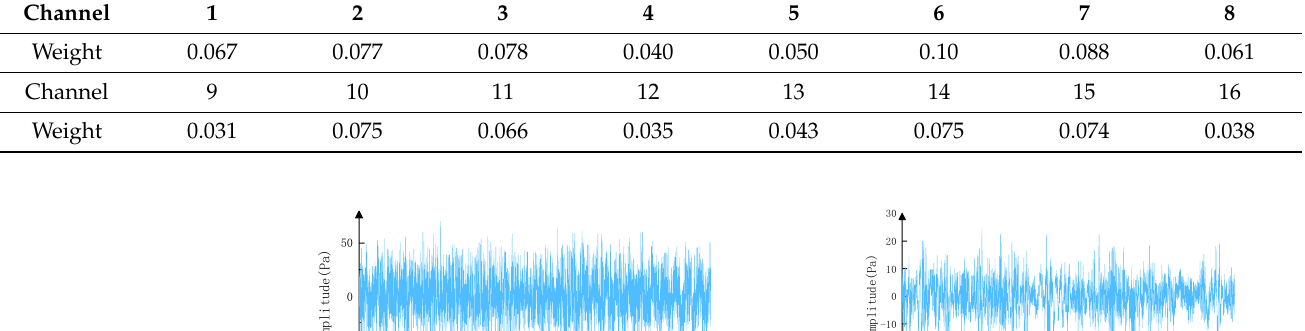
Table 4. Weight of each channel.